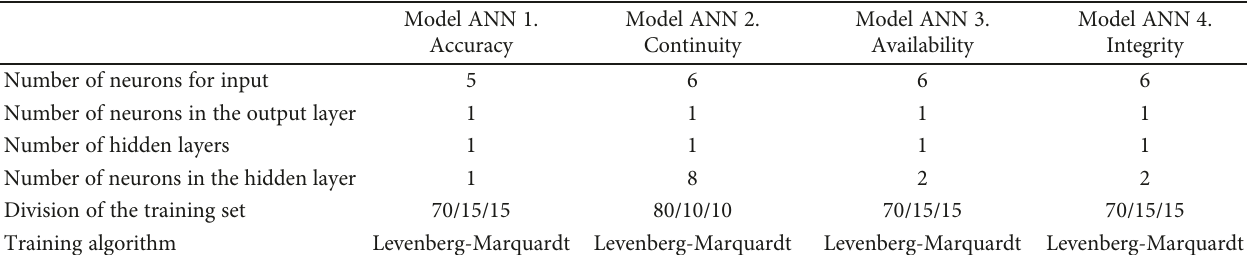
Table 1: Comparison of network structure in individual